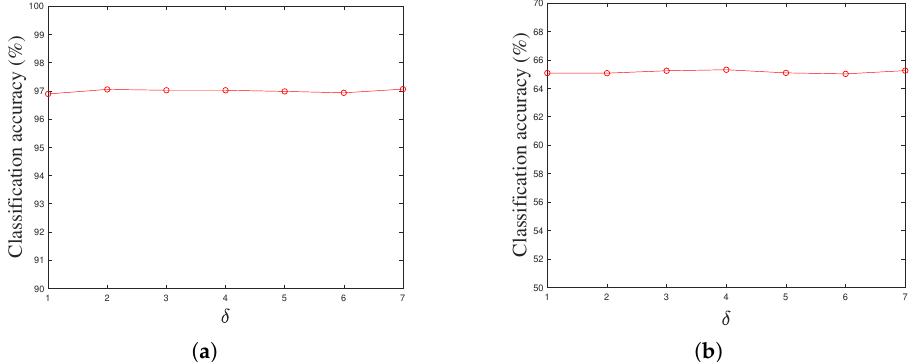
Figure 8. The classification accuracy versus parameter δ on ( a ) the Yale face dataset, and ( b ) the Caltech 101 object dataset by fixing the parameters λ , γ , η and k